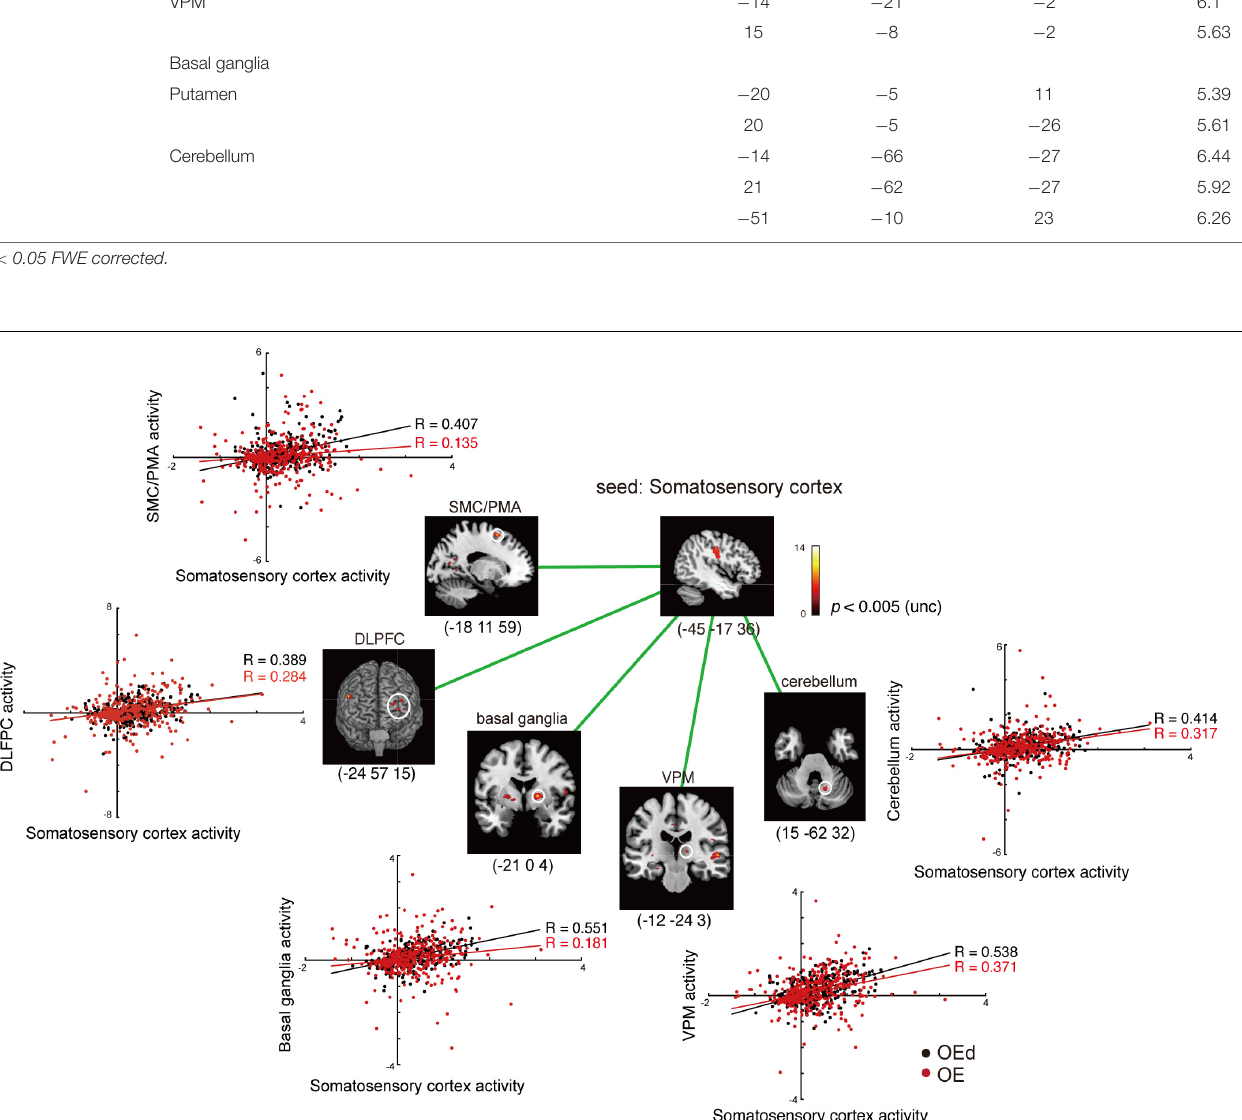
Frontiers in Aging Neuroscience |